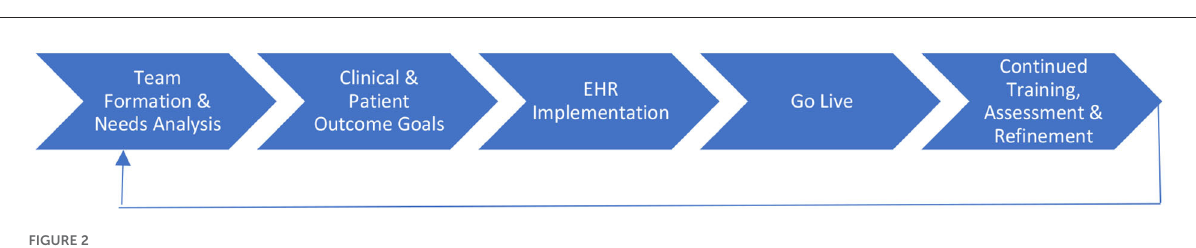
FIGURE2 Healthcare delivery science